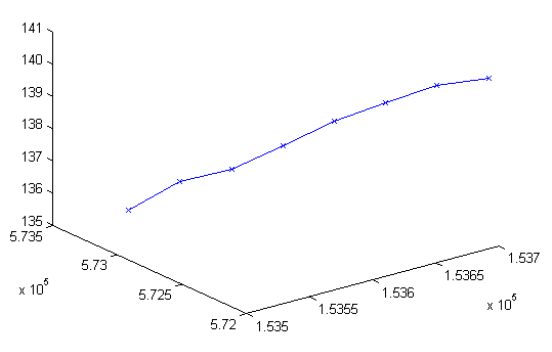
Figure 2. An example for a profile over which relative height evaluation was carried out